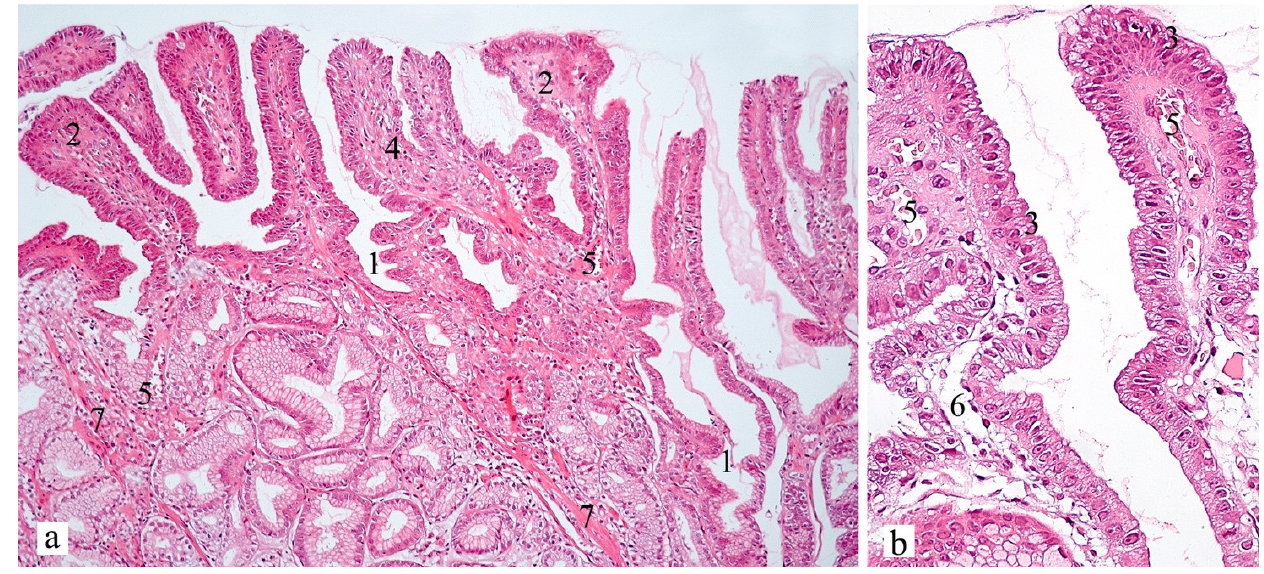
Figure 3. Gastric antral mucosa in patient A., 59 years old. Hematoxylin and eosin, ( a ) ×100, ( b ) ×400. Signs of foveolar hyperplasia with the presence of tortuous gastric pits (corkscrew appearance, (1)) and papillary deformity of the surface (2). Decreased mucus-producing activity of mucocytes with hyperchromic enlarged nuclei (reactive nuclei, (3)). In the lamina propria there is a scanty mononu- clear infiltrate (4), the presence of ectatic blood vessels (5), edema (6). An increase in the number ( hyperplasia ) of cells of muscularis mucosa with the formation of branching fibers surrounding the glands (7) can be noted.